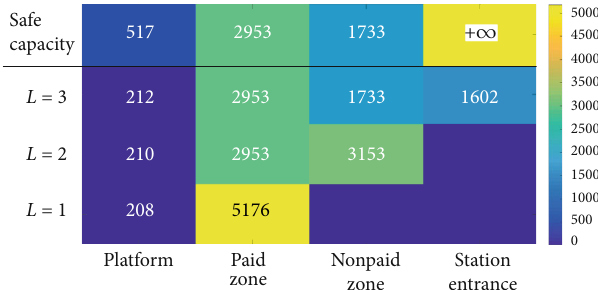
Figure 9: The MAP in the key area with di ff erent control levels at CU